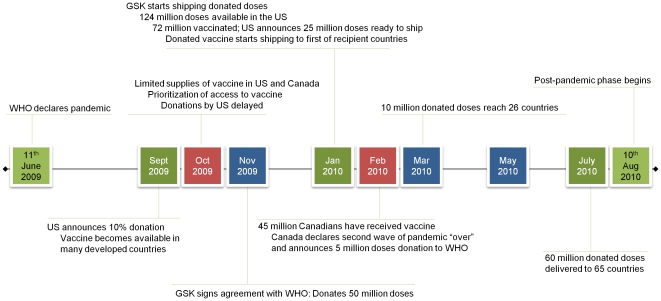
Timeline of the 2009 H1N1 Pandemic.